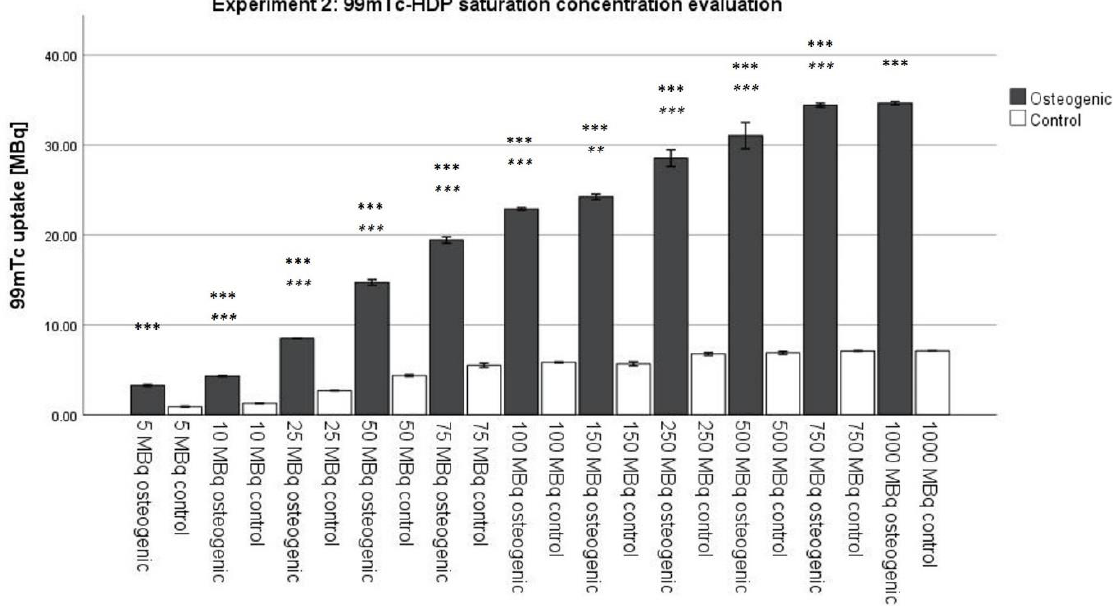
Figure 3. Mean 99m Tc-HDP uptake as measured by the dose calibrator when testing for the saturation concentration. The error bars show the standard deviation. Stars indicate significant differences: bold stars mean a significant difference between an osteogenic group and its corresponding control group. Stars in italics indicate a significant difference between an osteogenic group and the previous osteogenic group. ** = significance 𝑝 ≤ 0.01 , *** = significance 𝑝 ≤ 0.001 . n = 6.